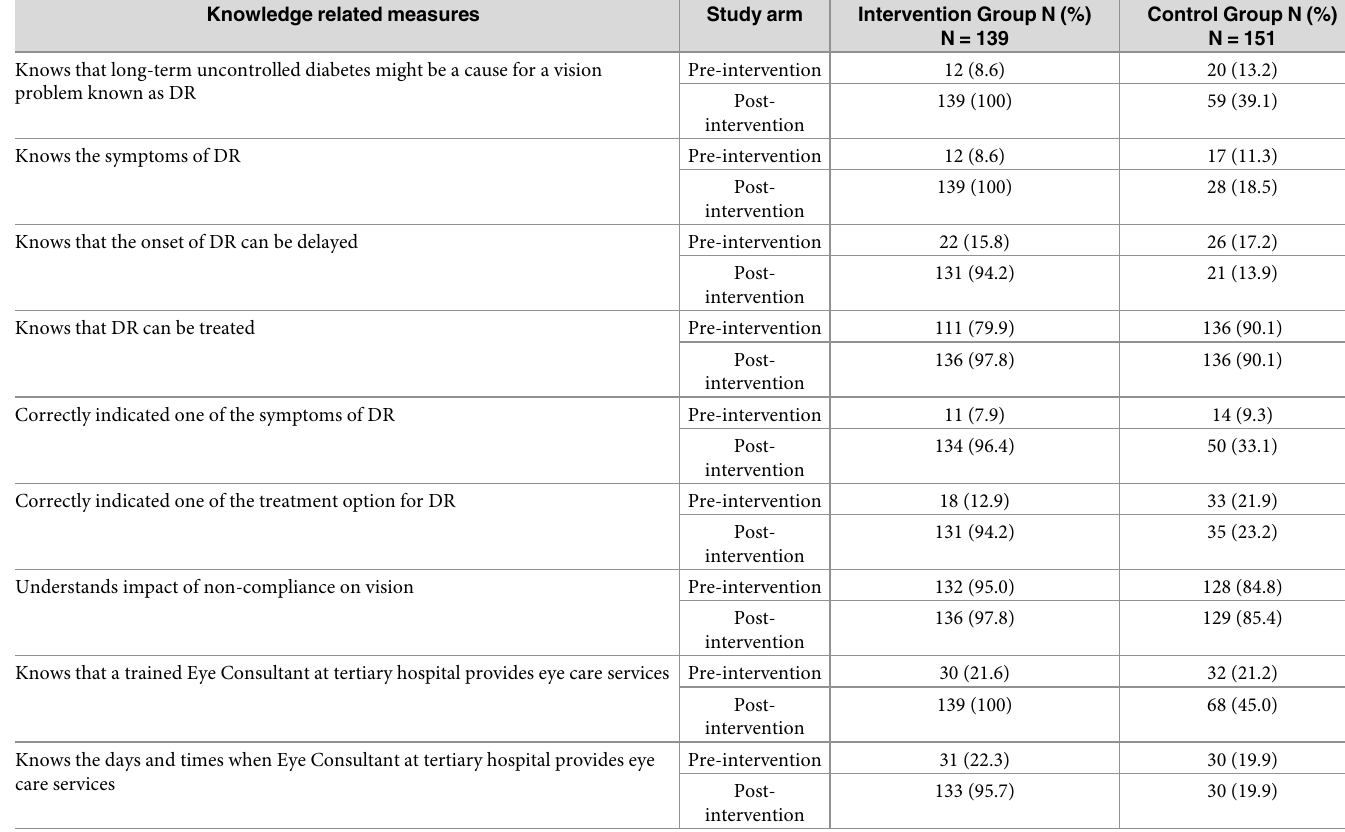
Table 3. Number of participants who responded positively to knowledge measures (secondary outcome) during pre and post